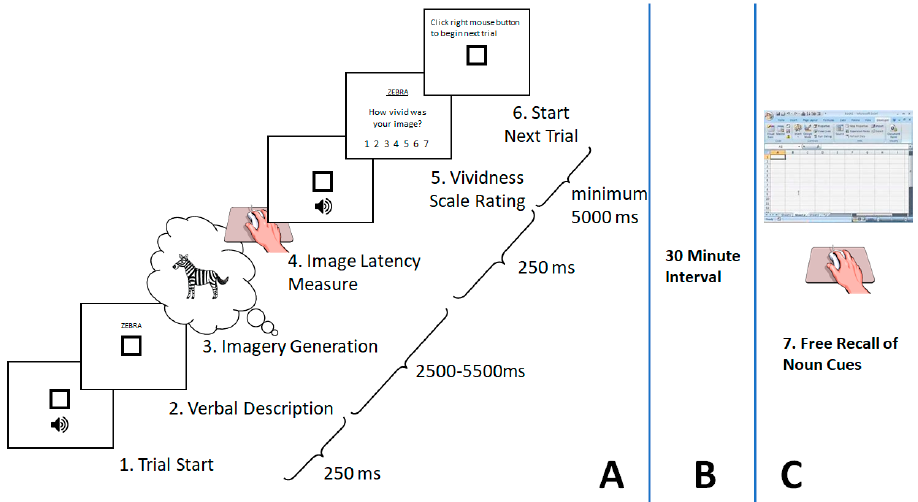
Figure 2. Schematic depicting the overall design of the imagery-generation incidental recall task. ( A ) Participants pressed the right mouse button to begin each trial (1). Upon clicking the mouse, an alerting beep was sounded, followed 250 ms later by the display of a noun-cue at the center of the screen (2). Participants were instructed to read the cue silently and as quickly as possible. They were immediately asked to generate an image that corresponded to the noun-cue (3). When participants felt that their mental image generation was at its most vivid state, they pressed the right mouse button (4). Upon pressing the button, another alerting beep was sounded, followed 250 ms later by a horizontal array of seven choices appearing near the bottom of the screen (5). From left to right, each button was labeled with one of seven vividness level descriptions in a seven-point scale format : ((1), “no image”; (2), “very vague/dim”; (3), “vague/dim”; (4), “not vivid”; (5), “moderately vivid”; (6), “very vivid”; and (7), “perfectly vivid”). Following the vividness response during the rating procedure, the array of buttons disappeared, and the display reverted back to a screen instructing the participant to click the mouse when they were ready to begin the next trial (6). A minimum of 5 s was needed between vividness response and the start of the next trial. ( B ) After completing the image generation phase, participants were told to take a break and fill out paperwork, including a debriefing session. ( C ) Exactly 30 minutes from their last trial, participants were asked to recall as many of the noun cues as possible on a blank excel spreadsheet (7).